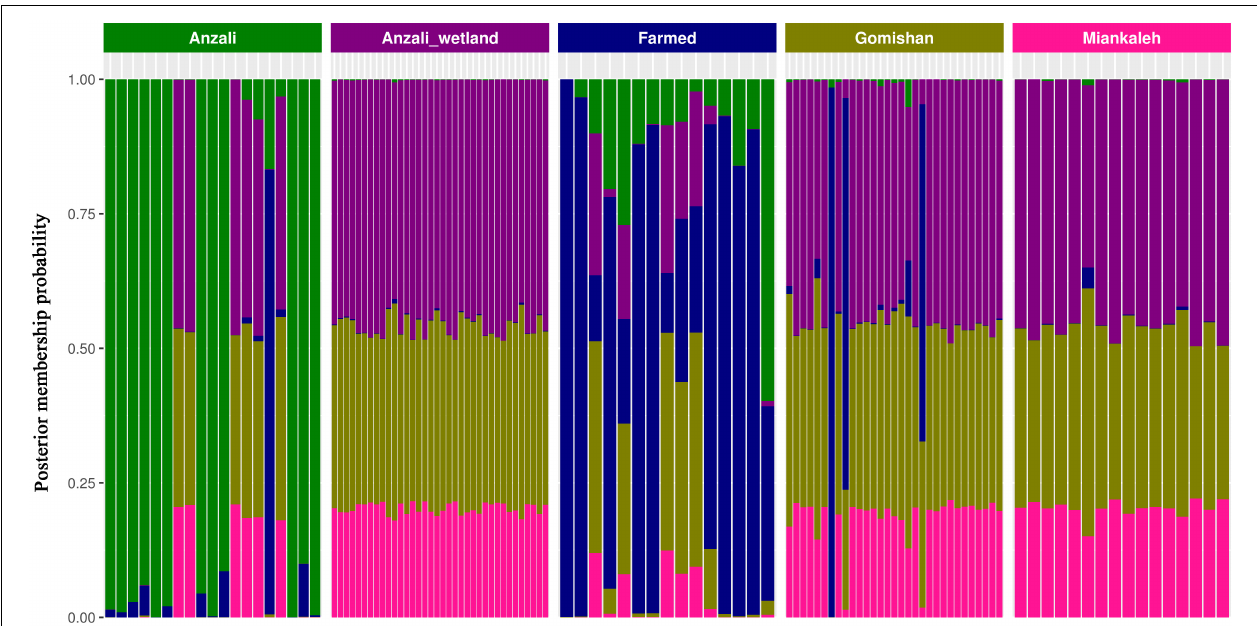
FIGURE 4 | Compoplot showing the assignments of population membership probability against their original populations. The X axis is the sample individuals and the Y axis represents the membership probabilities, fill colors indicate the population of origin.